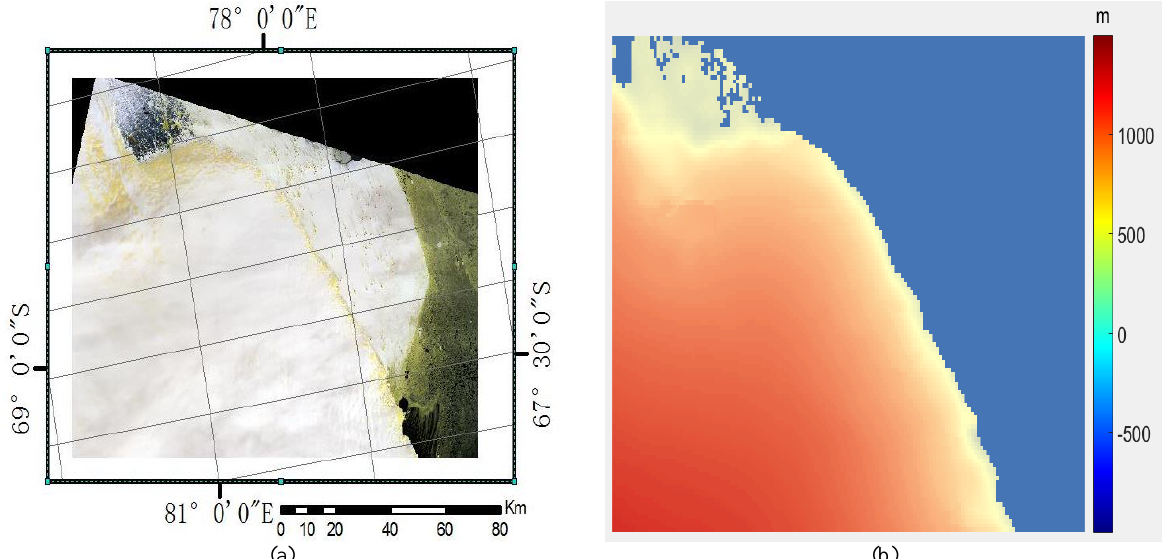
Fig.3. (a) Landsat-8 OLI image; (b) DEM of the selected region using croysat-2 elevation data